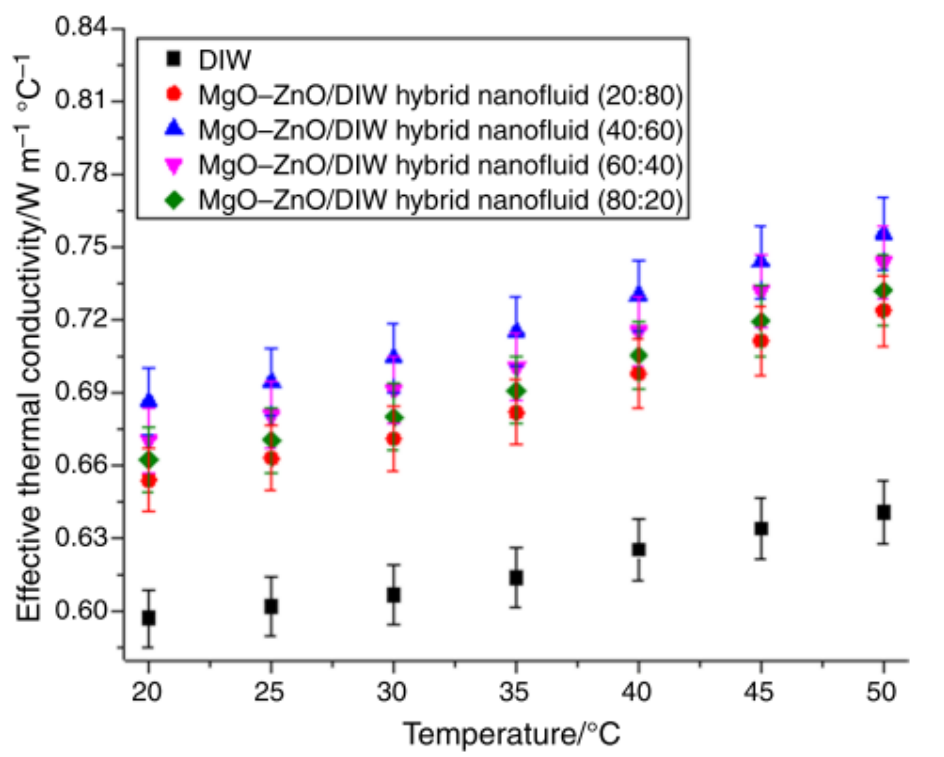
Figure 7. Effect of increasing temperature on effective thermal conductivity of 0.1 vol% MgO– ZnO/DIW nanofluid under varying mixing ratio [43].